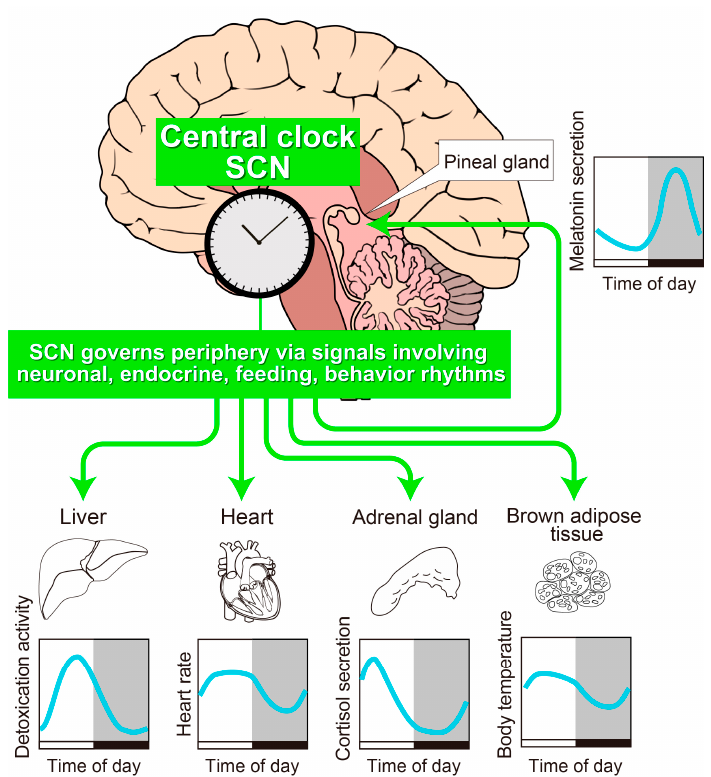
Figure 1. A schematic drawing of the architecture of the body clock. Most physiological processes exhibit circadian oscillations, which are synchronized by a central pacemaker located in the suprachiasmatic nucleus (SCN) of the anterior hypothalamus. Physiological rhythms in peripheral tissues such as liver, heart, adrenal gland, brown adipose tissue, and pineal gland are synchronized by an array of direct or indirect signals from the SCN. White and black bars indicate 12-h light/12-h dark cycle. Gray shading indicates the dark phase.